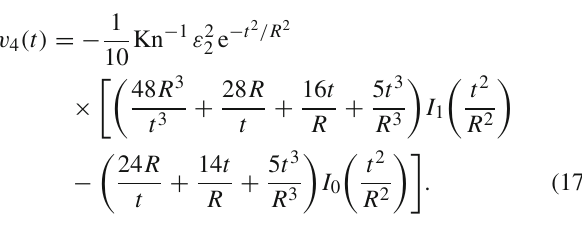
Fig. 8 Time dependence of quadrangular flow v 4 in systems with on average N resc . ≈ 0 . 02(left)or0 . 14(right)rescatteringsperparticle.The top panels are for a system with an initial quadrangularity ε 4 = 0 . 15 and ε 2 = 0; the bottom panels for an initial state with ε 2 = 0 . 15 and